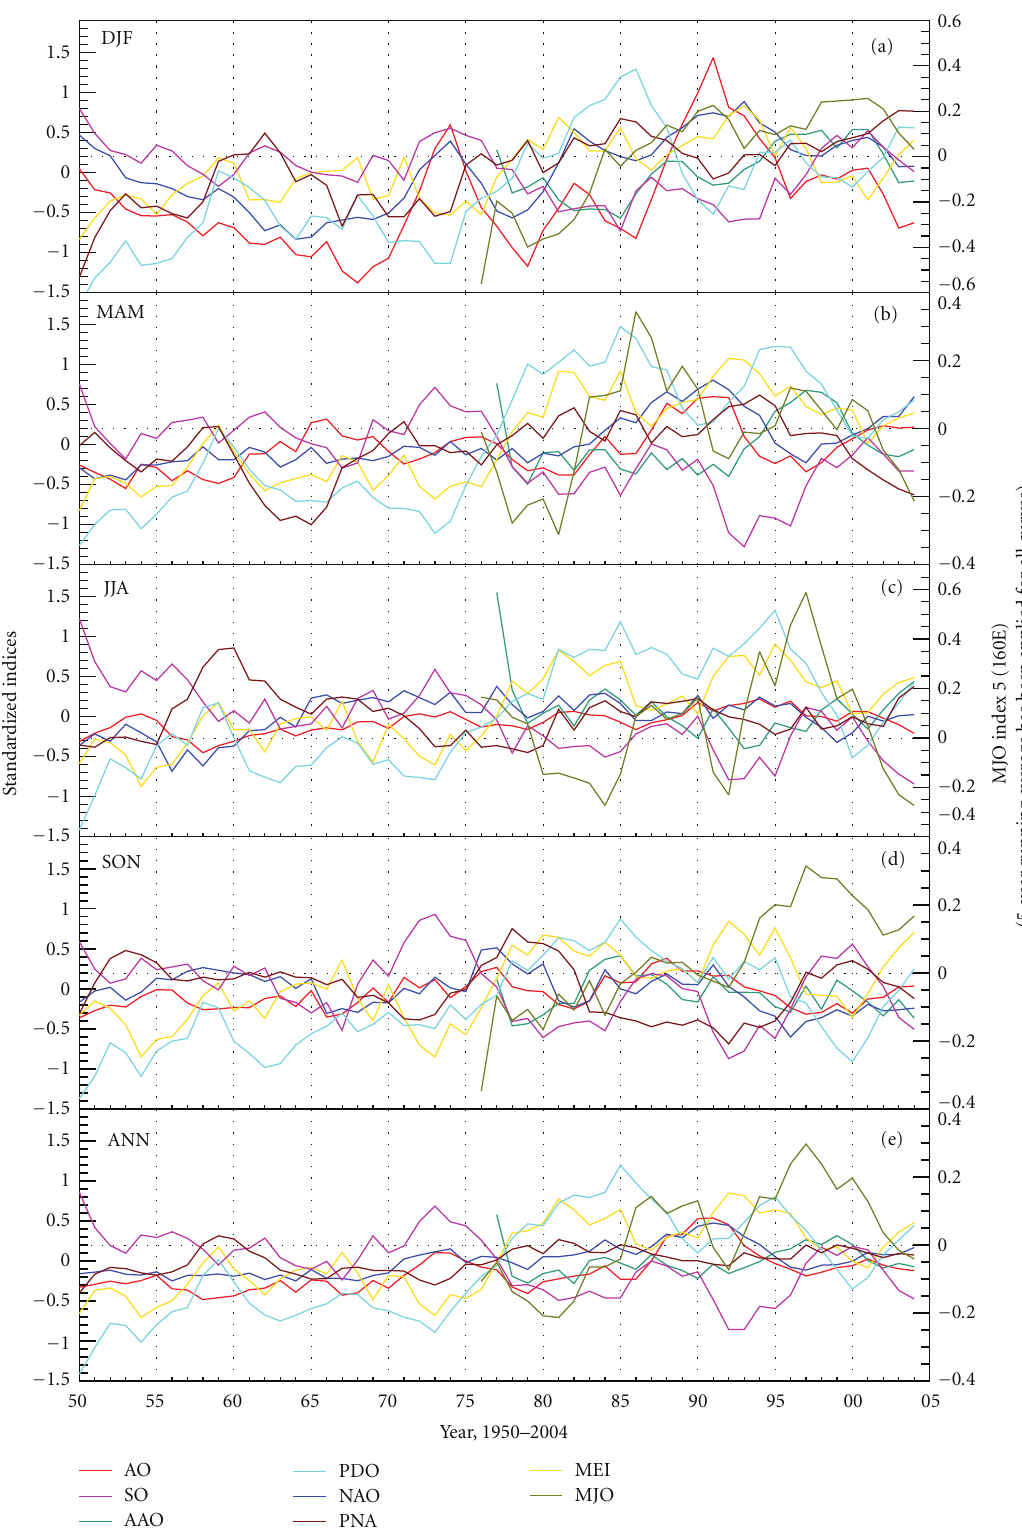
Figure 15: Time series of the eight commonly used climate indices in winter (DJF), spring (MAM), summer (JJA), autumn (SON) and the annual mean over the period